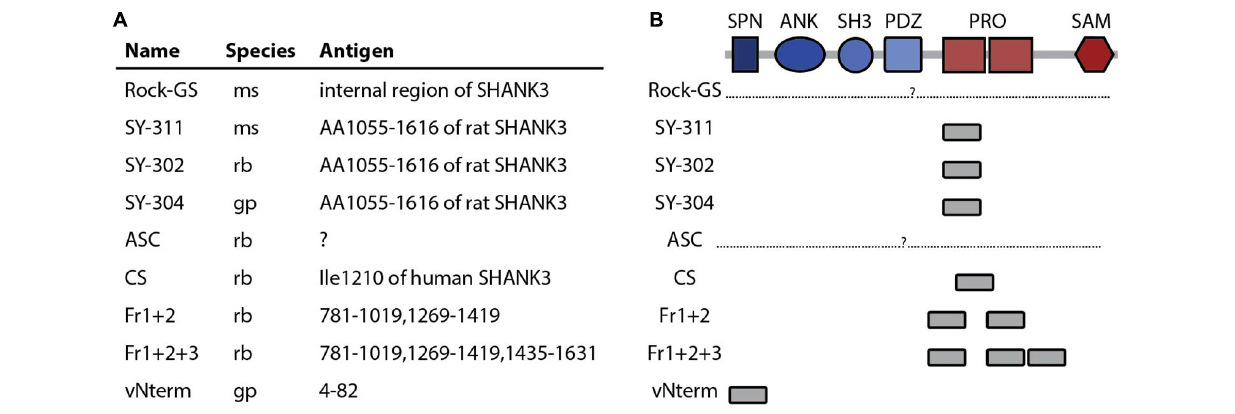
FIGURE 1 | SHANK3 antibodies used in this study. (A) Name, company, catalog number, species and, if know, the antigen of the nine SHANK3 antibodies used in this study are listed. (B) The protein domains of SHANK3 are given and the location of the antibody binding is indicated. SPN (Shank/ProSAP N-terminal